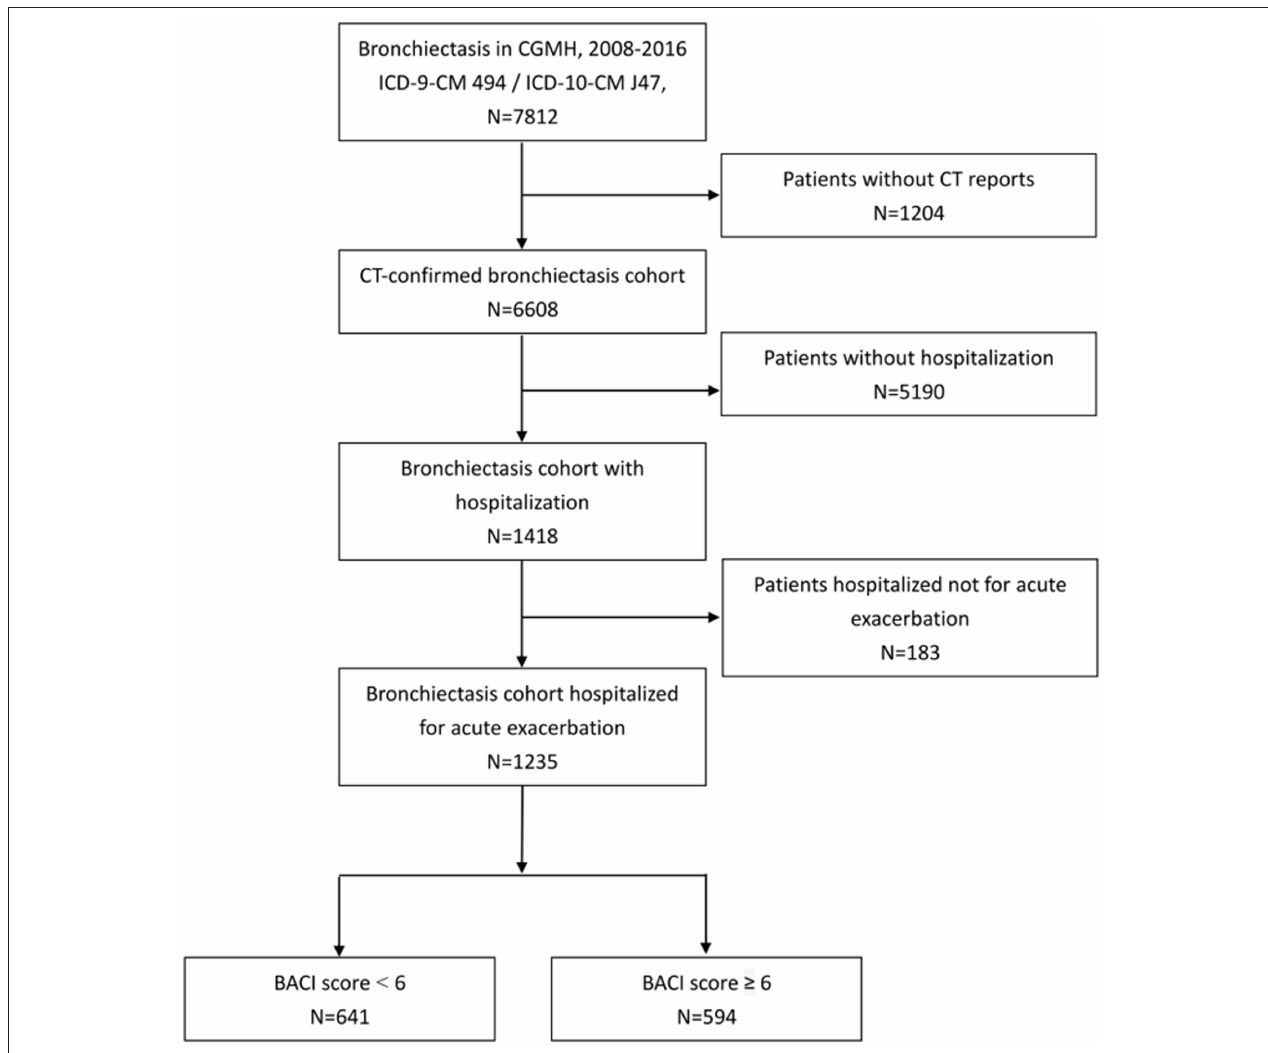
FIGURE 1 | Flow diagram of enrolled